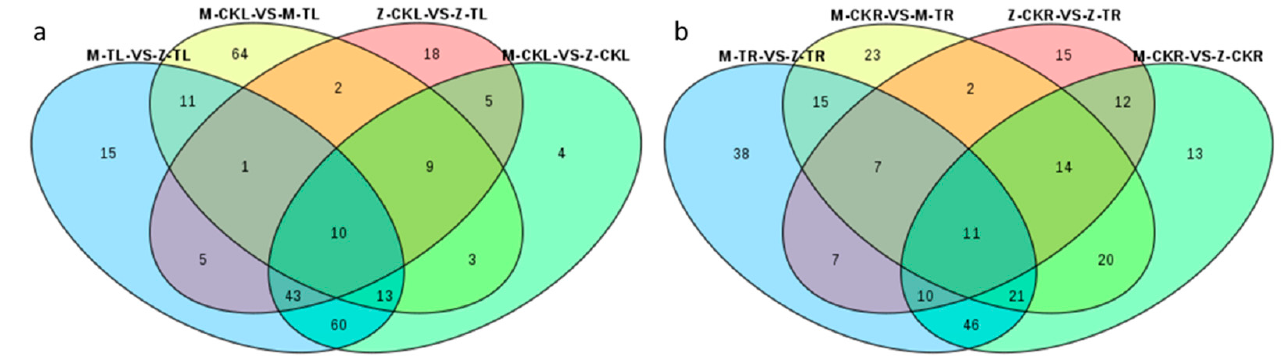
Figure 8. Venn diagrams of DAMs in leaves and roots among different combinations. ( a ) The Venn diagram of DAMs in leaves among different combinations. ( b ) The Venn diagram of DAMs in roots among different combinations. The KEGG pathway analysis of M-CKR vs. M-TR showed that DAMs were mainly enriched in the metabolic pathways, biosynthesis of secondary metabolites, biosynthe- sis of antibiotics, biosynthesis of amino acids, and so on (Figure S18). The top three VIP values of metabolites were L-arginine, chlorogenic acid, and cryptochlorogenic acid. LysoPC 18:3 and lysoPC 18:1 were induced to accumulate by salt stress in M9T337 (Figure 7d, Table S9). The KEGG pathway analysis of Z-CKR vs. Z-TR showed that DAMs were enriched in the metabolic pathways, biosynthesis of secondary metabolites, microbial metabolism in diverse environments, biosynthesis of antibiotics, and so on (Figure S19). The top three VIPs of metabolites were 3-hydroxyphloretin, L-norleucine, and L-leucine. L-cysteine and sanguisorbigenin were induced to accumulate by salt stress in ZM-4 (Figure 7e, Table S9). The KEGG pathway analysis of M-TL vs. Z-TL showed that DAMs were enriched in the biosynthesis of secondary metabolites, biosyn- thesis of amino acids, flavonoid biosynthesis, flavone and flavonol biosynthesis, and so on (Figure S20). The top three VIPs of metabolites were 2 α ,3 α ,19 α ,23-tetrahydroxy-12- ursen-28-oic acid, quercetin-3-O-glucoside, and 1-O-feruloyl- β -d-glucose. Sanguisor- bigenin only accumulated in Z-TR (Figure 7f, Table S9). The Venn diagram results showed that 18 metabolites were produced in re- sponse to salt stress in the roots of both ZM-4 and M9T337, including two flavonoids (isorhamnetin-3-O-glucoside and quercetin-3-O-arabinoside), three phenolic acids (5-O-p-coumaroylquinic acid, 1-O-sinapoyl- β -D-glucose, and propyl 4-hydroxybenzoate), five organic acids (L-malic acid, muconic acid, 3-isopropylmalic acid, 2-propylmalic acid, and 2-isopropylmalic acid), four amino acids and their derivatives (L-glutamic acid, L-leucine, L-proline, and L-valine), one nucleotide and its derivative (adenosine 5’-monophosphate), one alkaloid (pterolactam), one terpenoid (2-hydroxyoleanolic acid) and one other (roseoside). Seven metabolites were specific to the response to salt stress for ZM-4, including one phenolic acid (5-O-p-coumaroylshikimic acid O-glucoside), two flavonoids (isorhamnetin-7-O-glucoside and rhamnetin-3-O-glucoside), one terpenoid (sanguisorbigenin), two organic acids (D-malic acid and 6-aminocaproic acid), and one other (3-dehydro-L-threonic acid) (Figure 8b, Table S10).